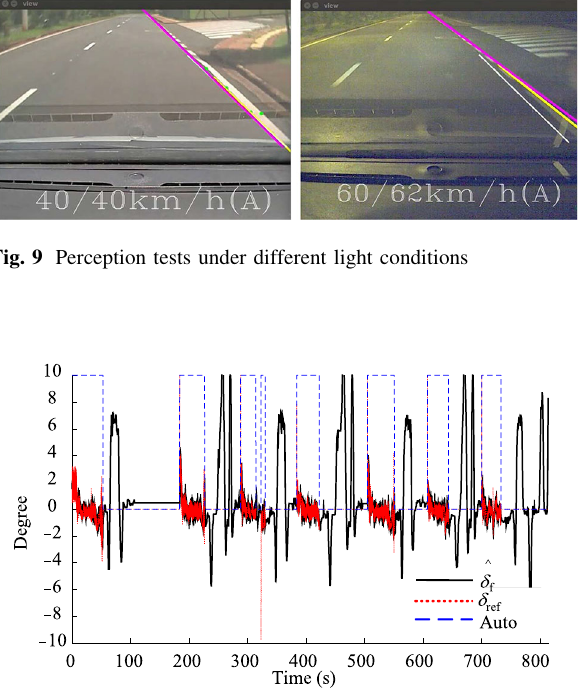
Fig. 10 Estimated angle of the wheels in the test and reference angle calculated by the path controller. Auto means the moments where autonomous system is activated